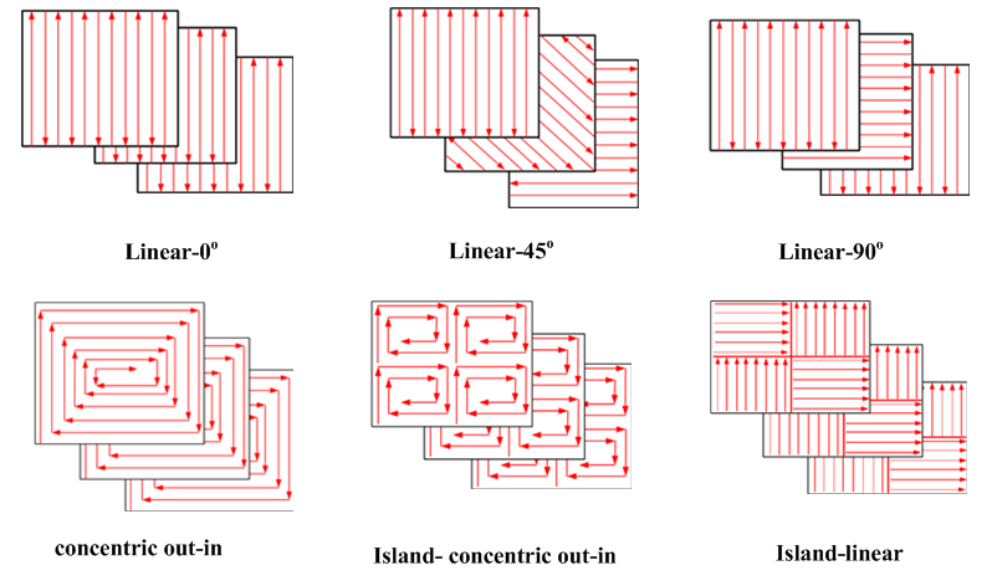
Figure 3. Six scanning strategies investigated in this study.